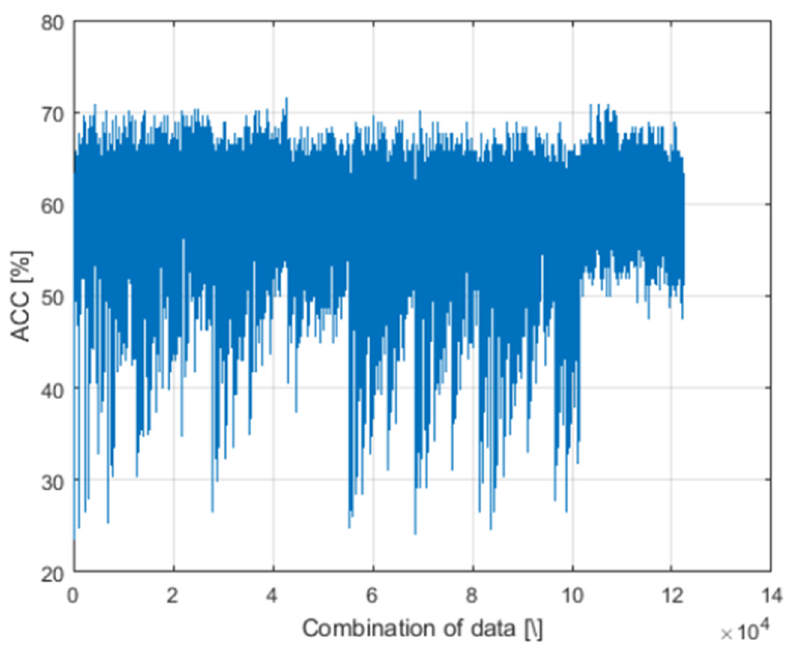
Figure 1. Decision tree of Artificial Intelligence analysis showing the overall values of accuracy (ACC). Table 4. The table below shows the top 10 cases and the different combinations of features and